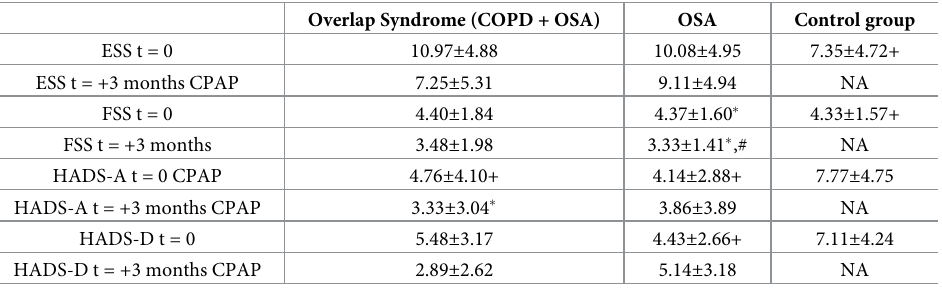
Table 3. Questionnaires’